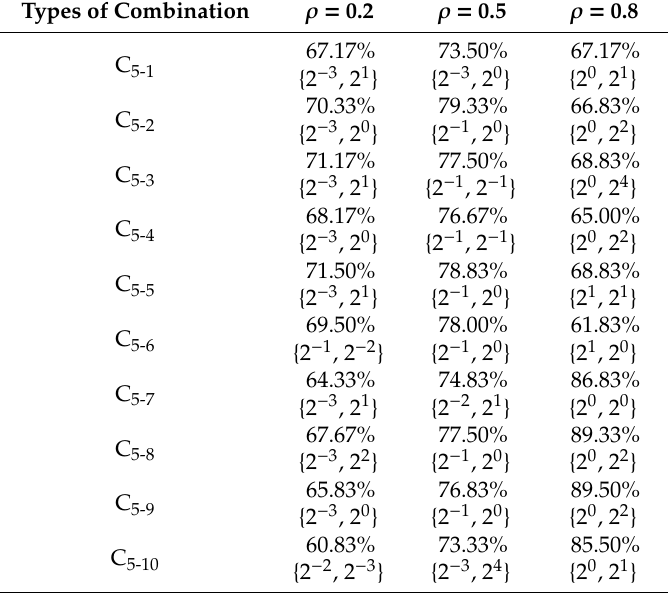
Table 6. Support vector machine (SVM) identification results, AIR -SVM {C, γ }, for ten combinations of faults of an MNP 5.